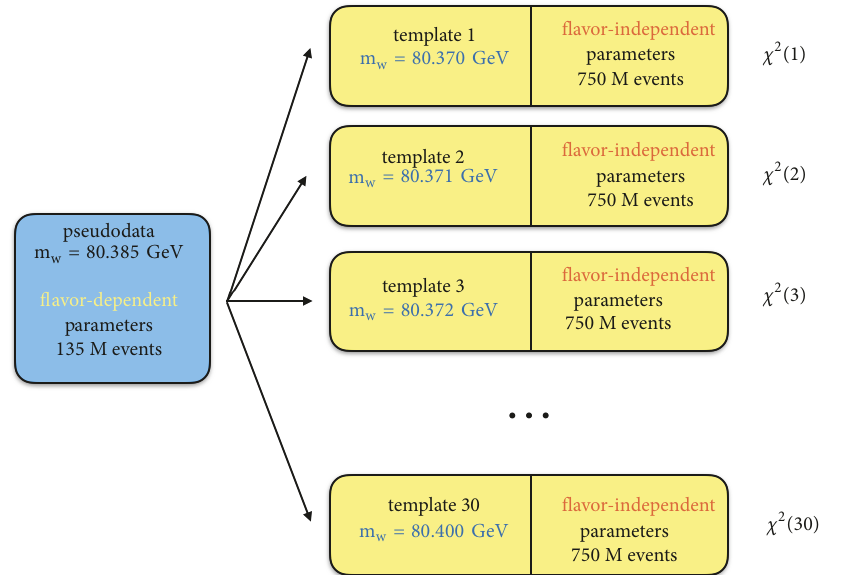
Figure 4: Flowchart for a template-fitprocedure to estimate shifts in 𝑚 𝑊 induced by the flavour dependence of the intrinsic quark transverse